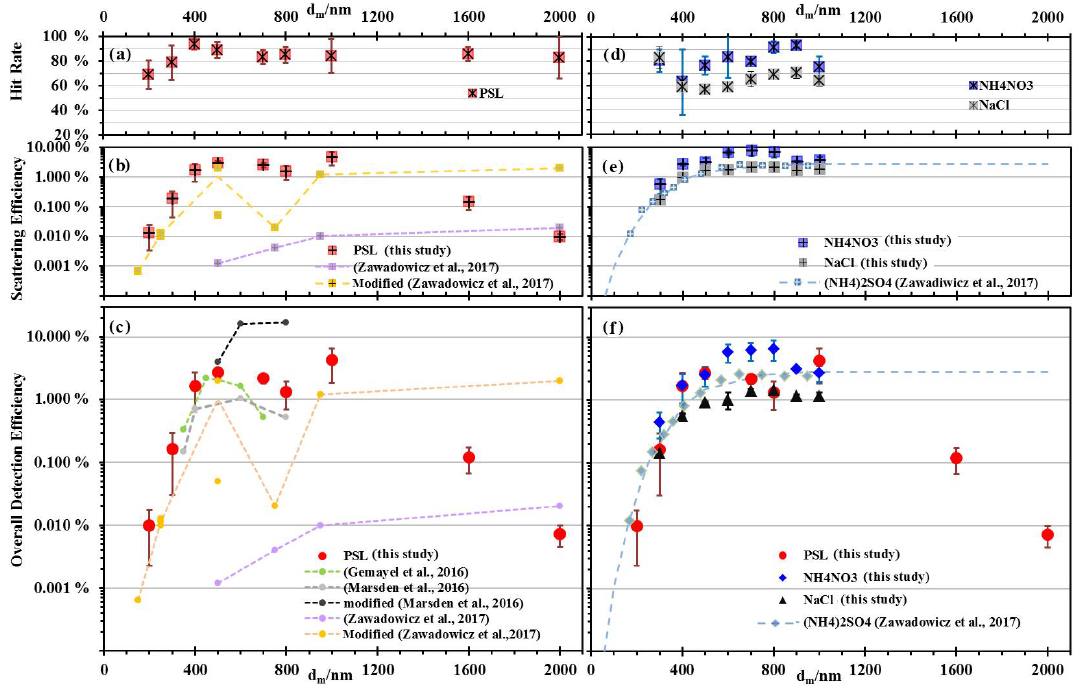
Figure 2. Hit rate (HR, a and d ), scattering efficiency (SE, b and e ), and overall detection efficiency (ODE, c and f ) for PSL, ammonium nitrate (NH 4 NO 3 ) , and sodium chloride (NaCl) salt particles as a function of mobility diameter, d m . Aerosol particles in this study were generated from a nebulizer and size-selected by DMA. In (b) and (e) , OCEs for PSL and ammonium sulfate ((NH 4 ) 2 SO 4 ) at the detection beam from the study by Zawadowlcz et al. (2017), corresponding to the SE defined in this study, are plotted for comparison. In (c) and (f) , ODE for PSL and salt particles from other studies (Gemayel et al., 2016; Marsden et al., 2016; Zawadowicz et al., 2017) are plotted for comparison. In this figure, dashed lines are used only to guide the